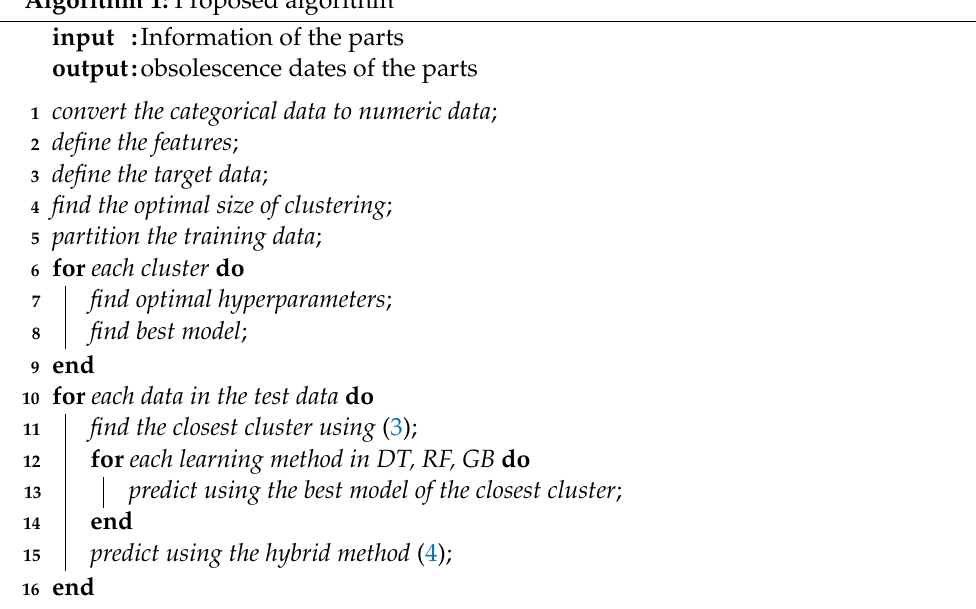
Algorithm 1: Proposed